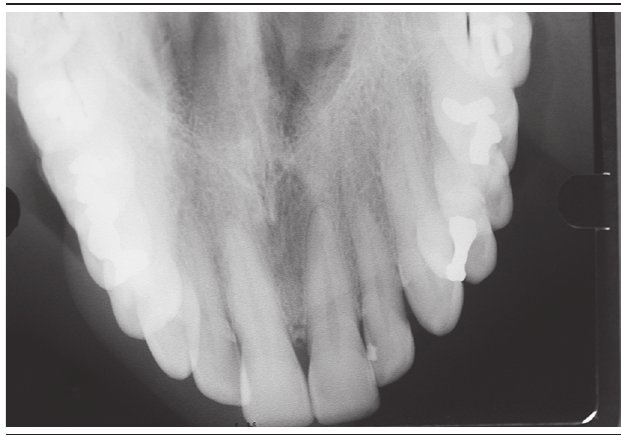
figurE 2 − Maxillary occlusal radiography showing unilocular radiolucent image related to the upper central incisors